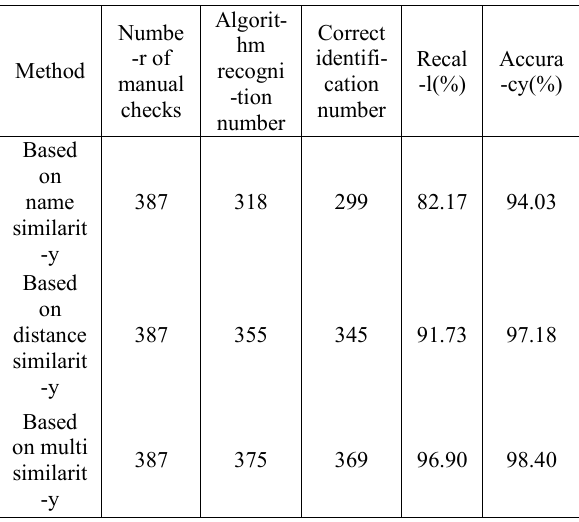
Table 3 . Statistics of experimental results of three POI point matching methods with the same